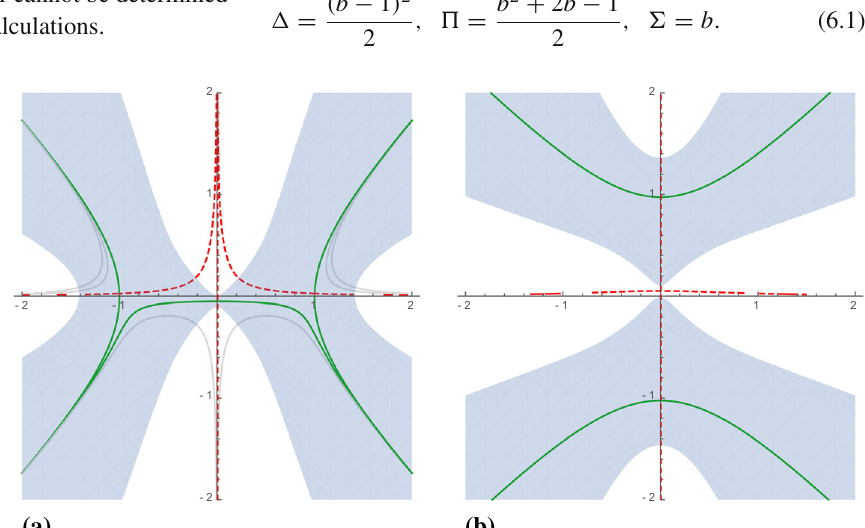
Fig. 7 Change in the structure of thimbles as the parameter a crosses the phase boundary a = 0. In both the figures, the green solid curves represent the thimbles, red dashed curves represent the anti-thimbles, and the grey solid curves represent the ghosts. The shaded regions represent the regions where Re ( S ) ≥ 0. The anti-thimble x = 0 has been offset to x = 0 . 01 for better visibility.